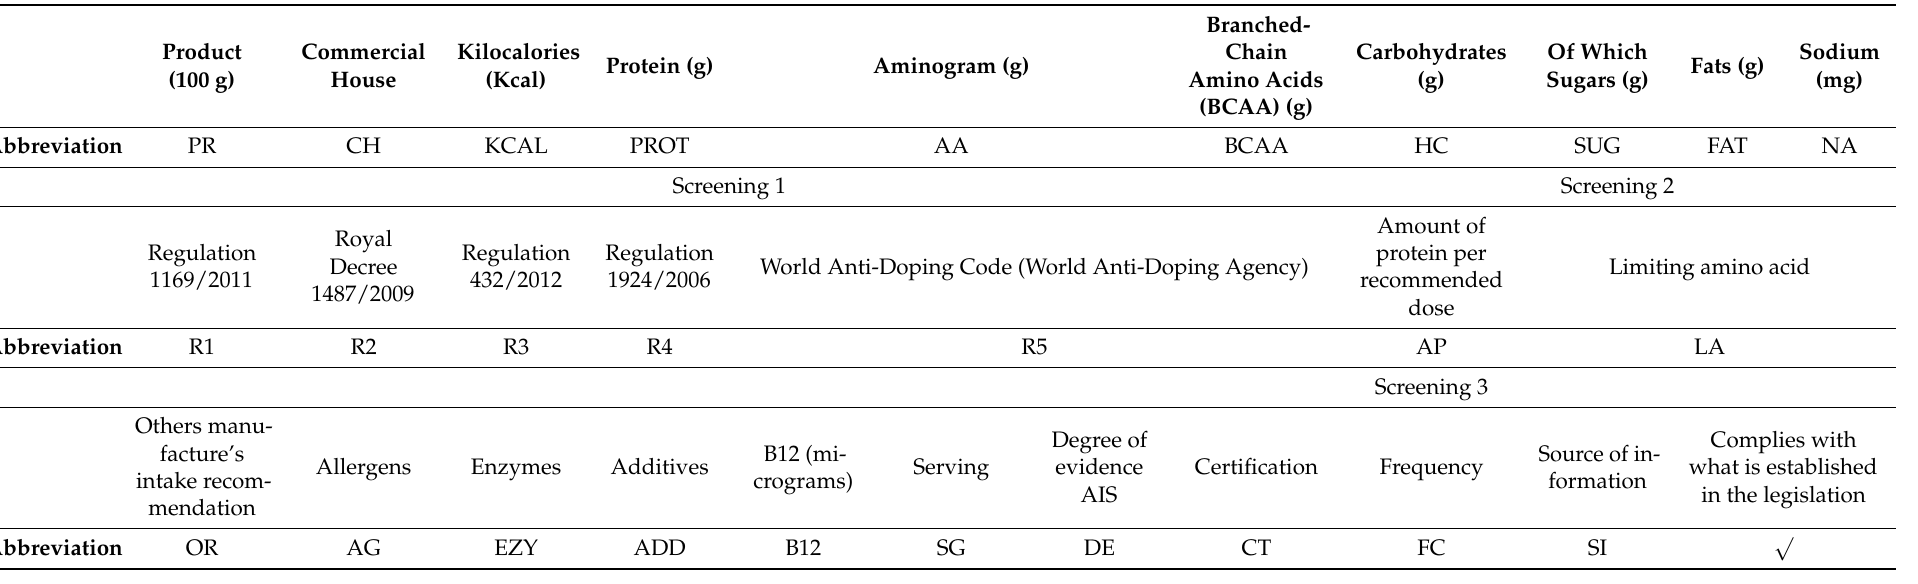
Table 2. Components included in the composition of protein isolate supplements database and how they are